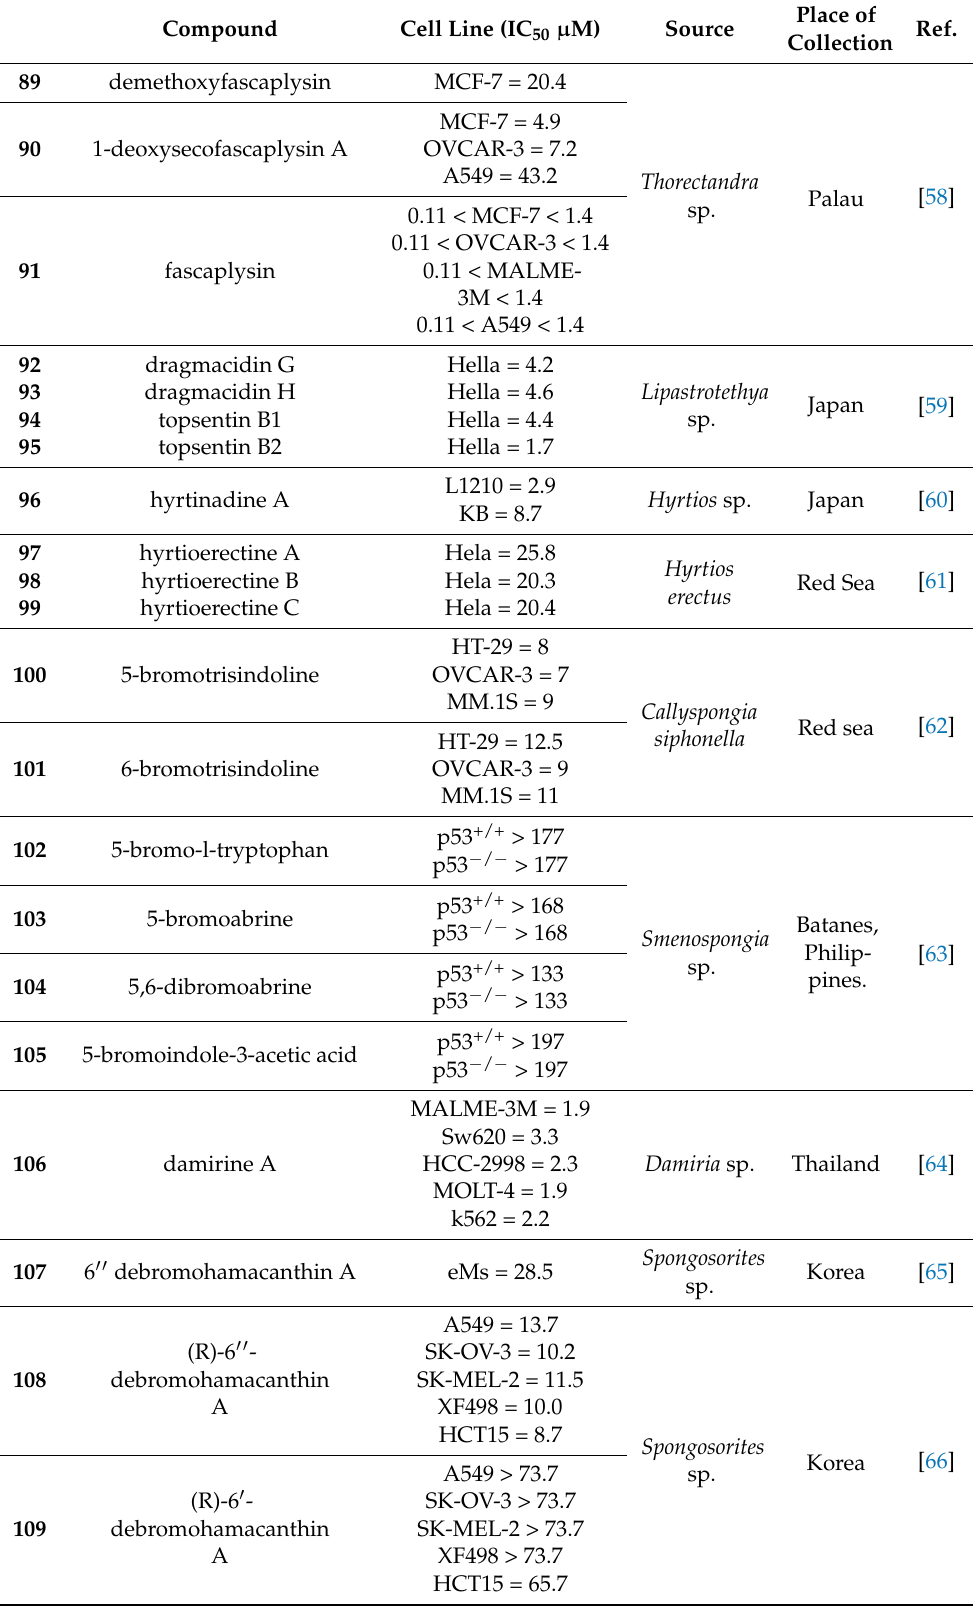
Place of Collection